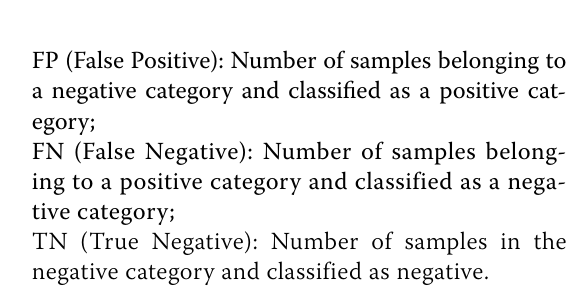
Table 7 The synonym examples